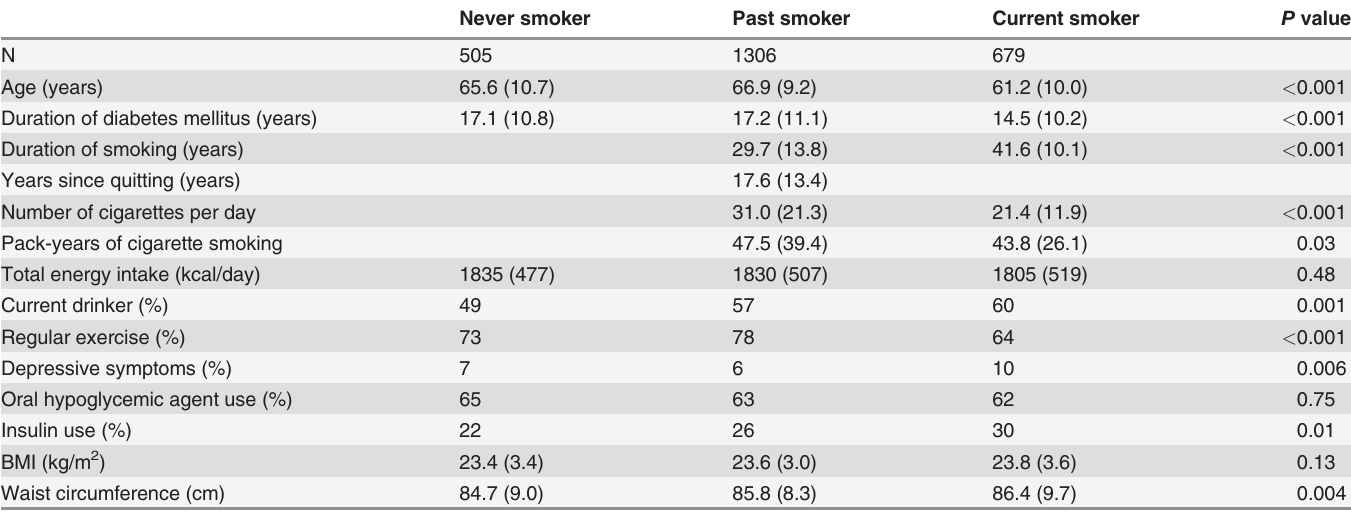
Table 1. Clinical characteristics of the study subjects according to smoking